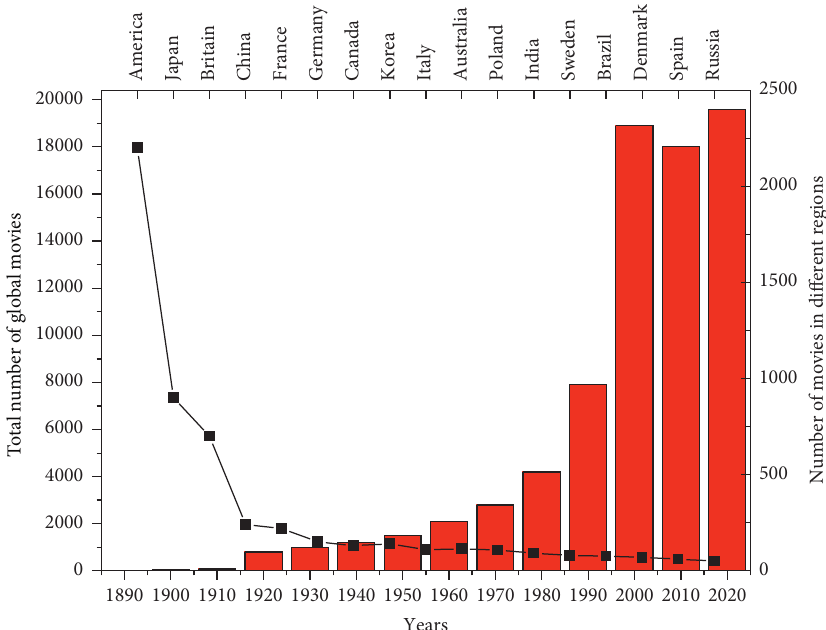
Figure 12: The trends of box office earning and average number of episodes with